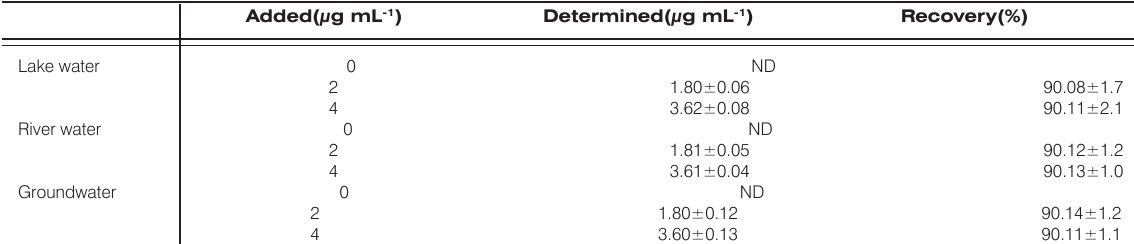
Table 3. Analytical results for ASPM in actual water samples